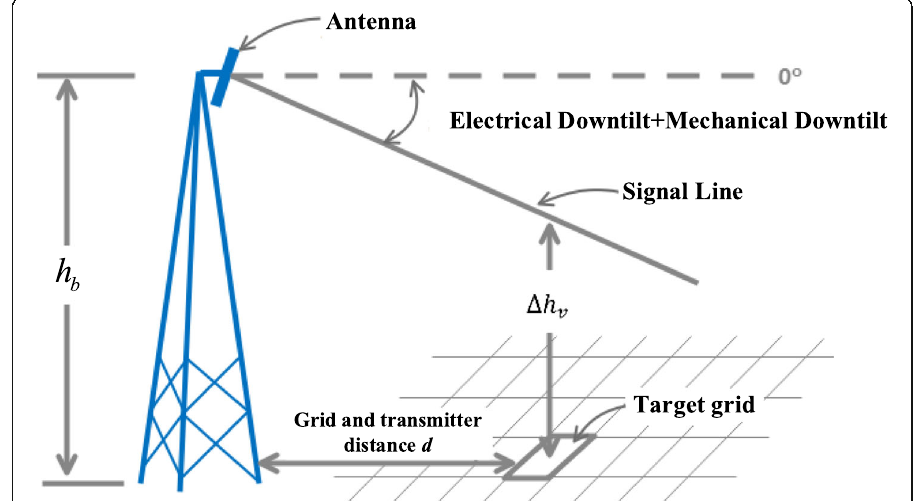
Fig. 3 Schematic diagram of Δ h